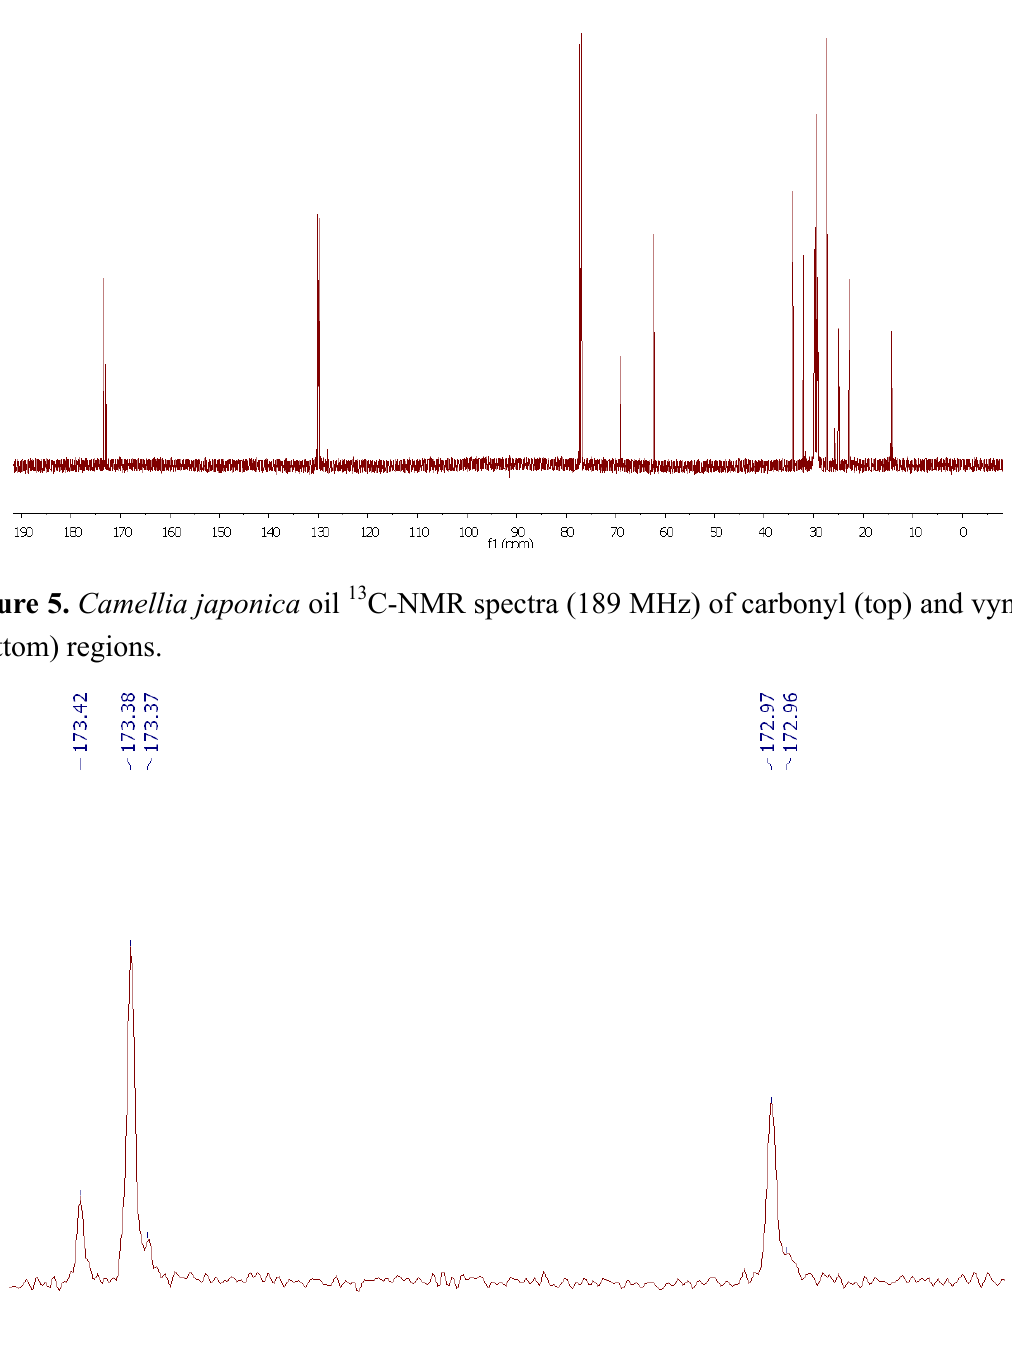
Figure 4. Camellia japonica oil 13 C-NMR spectra (189 MHz).